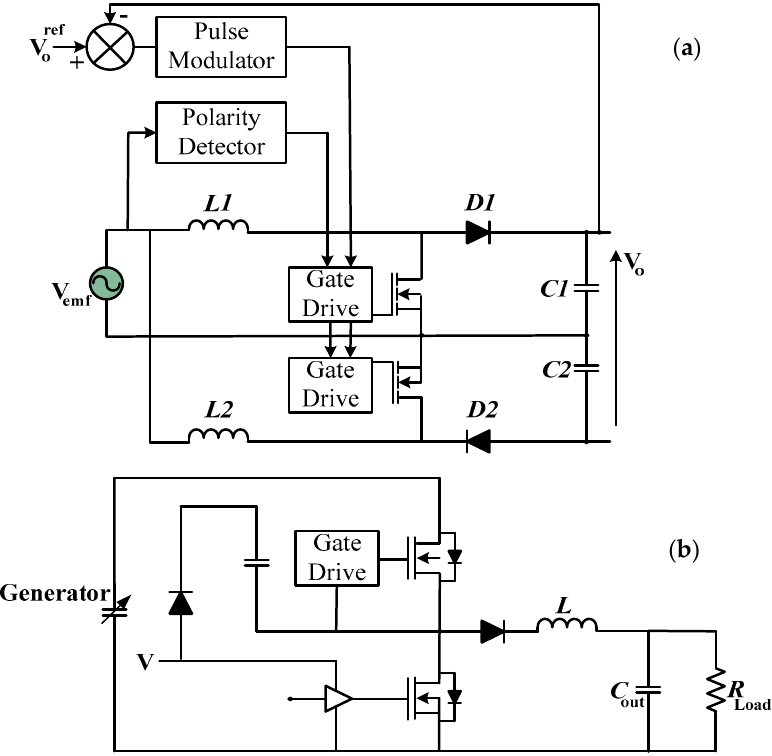
Figure 27. A double-split boost converter ( a ), buck converter ( b ) [132]. Reprinted with permission from ref. [132]. Copyright 2007 Springer Nature.